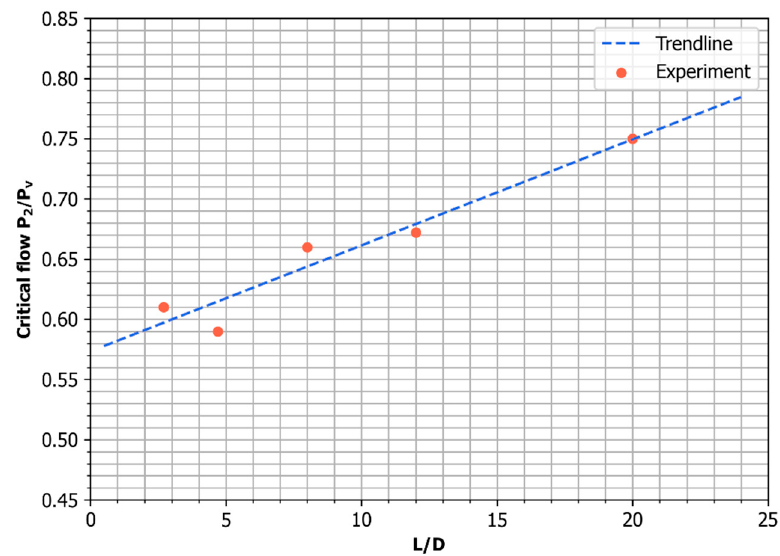
Figure 11. Effect of the L/D ratio on the critical flow transition.